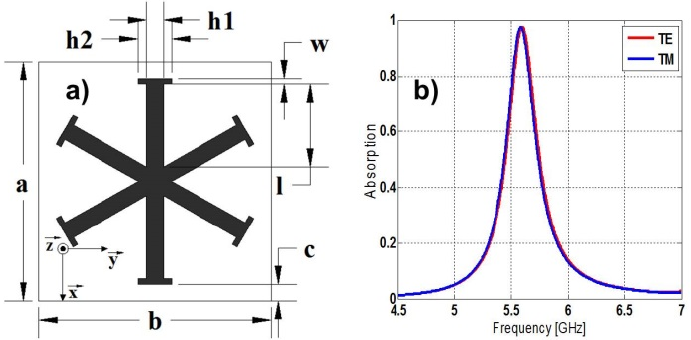
Figure 1. ( a ) Unit-cell geometry; ( b ) absorption for TE and TM